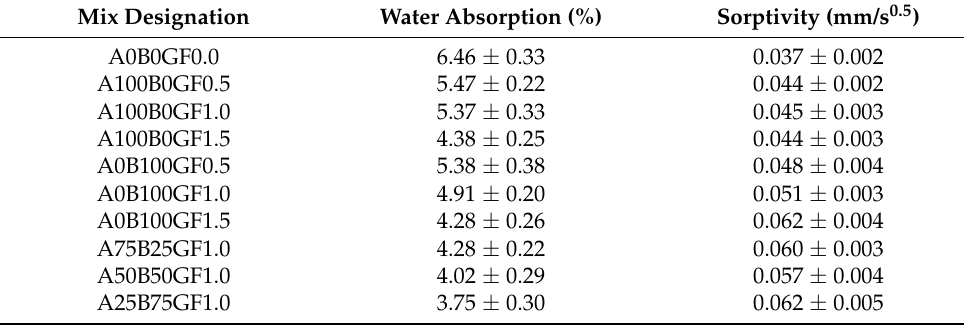
Table 10. Water absorption and sorptivity of geopolymer concrete mixes.